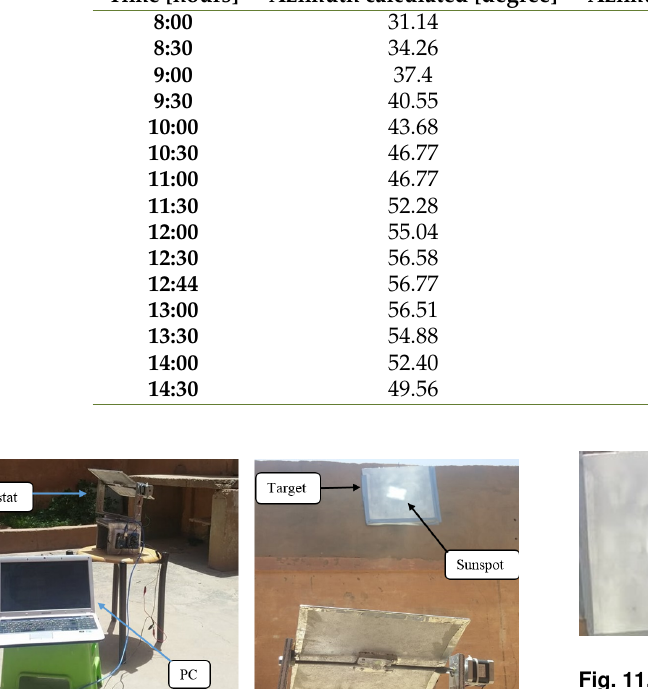
Fig. 11. Image of the sunspot on the target (elevation test)